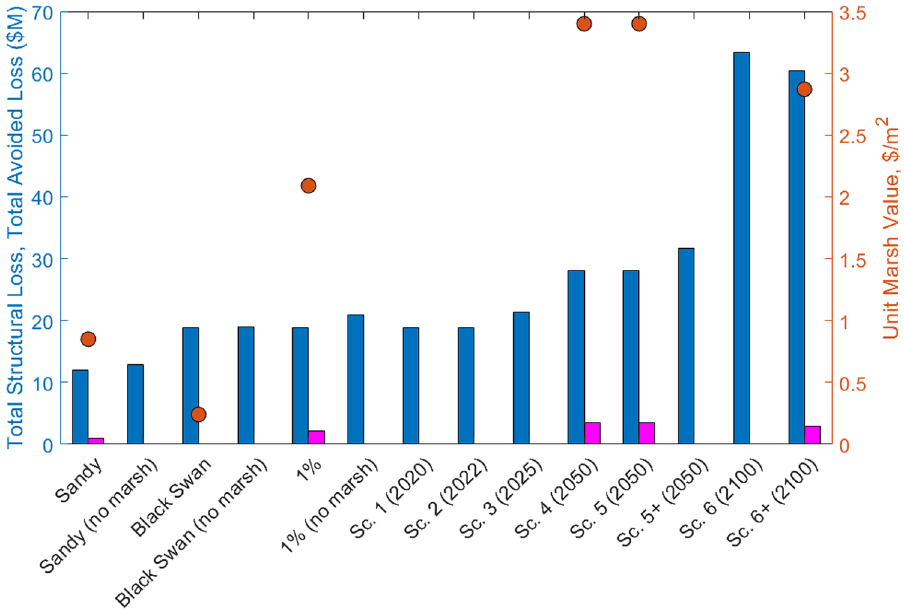
Figure 5. Total structural loss (blue bars), total avoided loss (magenta bars), and unit marsh value (orange circles) for scenarios are listed in Table 1.